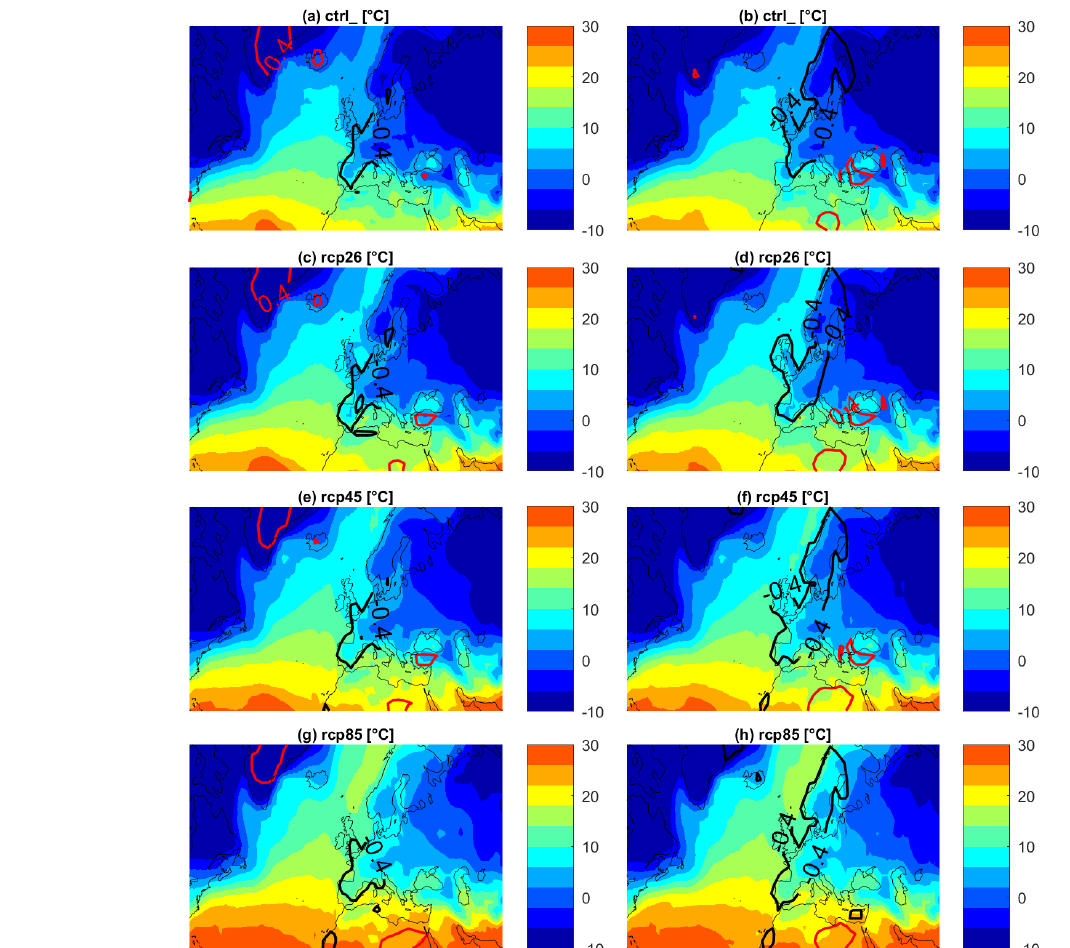
Figure 9. The figure shows 2m temperatures in PlaSim simulations: average of the 2m temperature [ ◦ C] for cluster 1 (a, c, e, g) and cluster 2 (b, d, f, h) of analogues. (a, b) Control run. (c, d) RCP2.6 run. (e, f) RCP4.5 run. (g, h) RCP8.5 run. Isolines represent positive (in red) and negative (in black) standardized